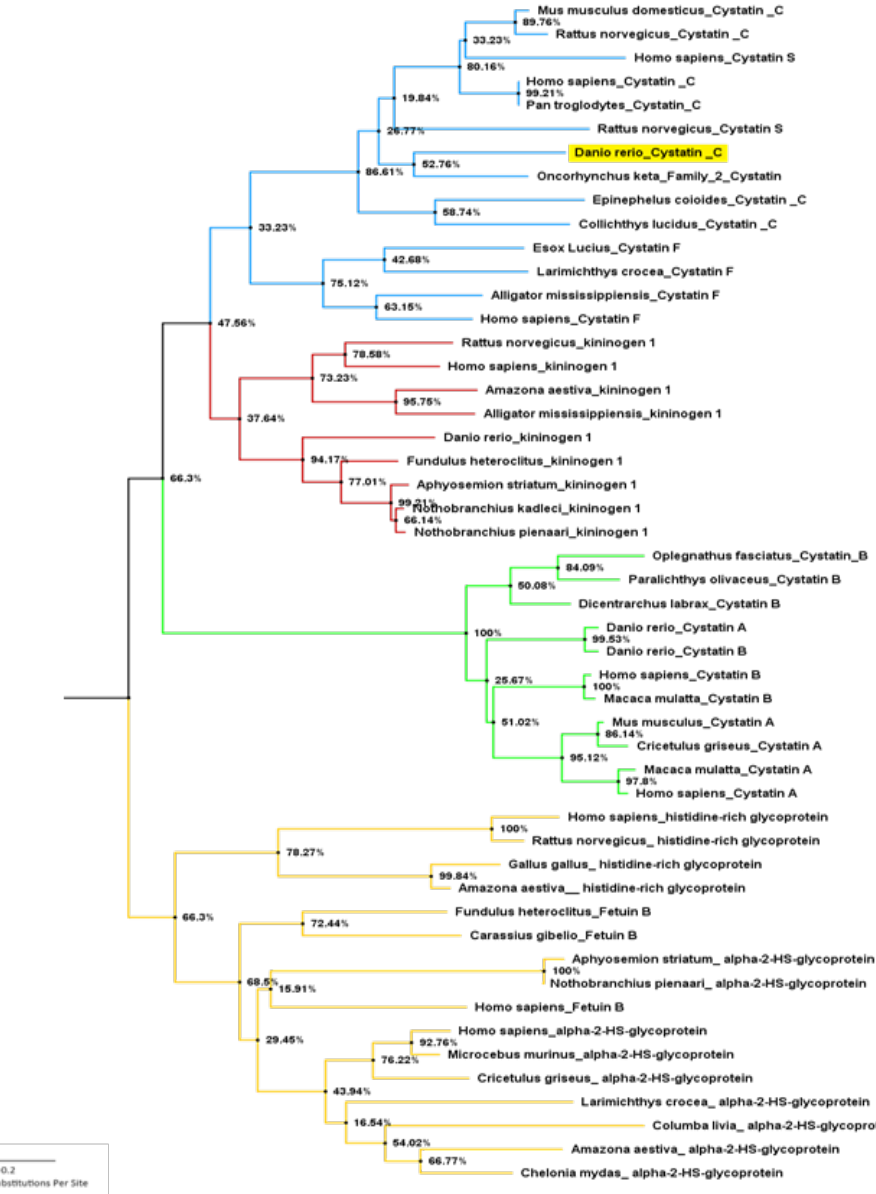
Figure 2. Refined phylogenetic tree. Type 1 cystatins in green, type 2 cystatins in blue, type 3 cystatins in red, and type 4 cystatins in orange. The Danio rerio amino sequence is highlighted in yellow.